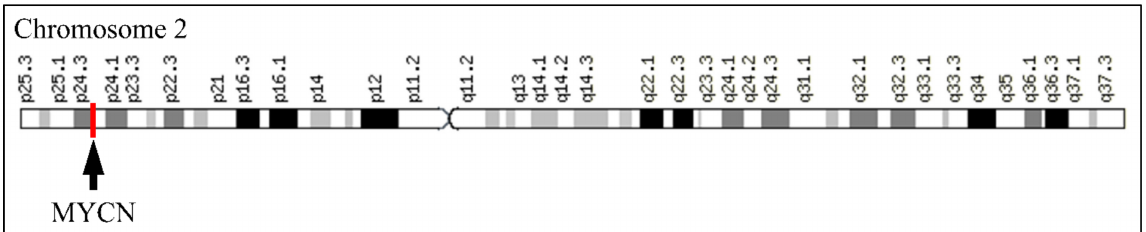
Figure 2. The location of MYCN on Chromosome 2.